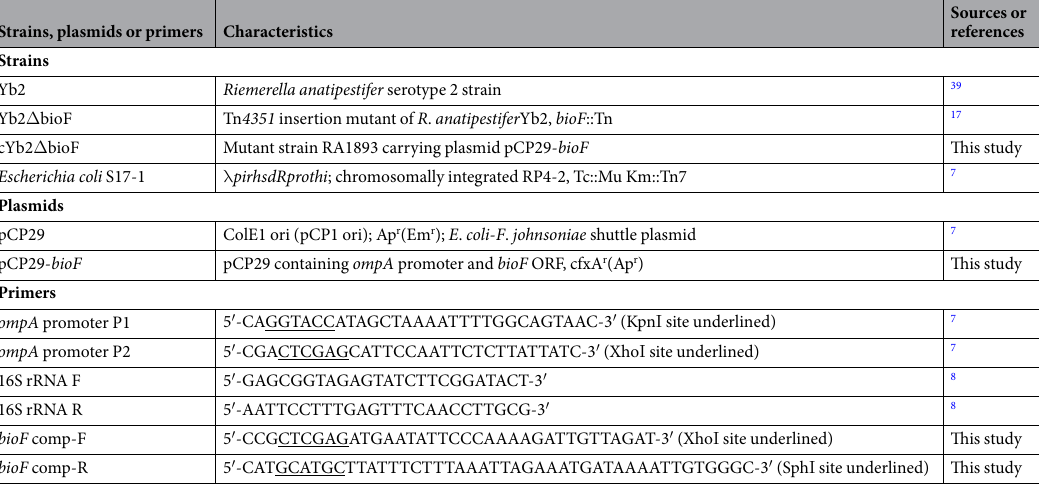
Table 2. Strains, plasmids and primers used in this